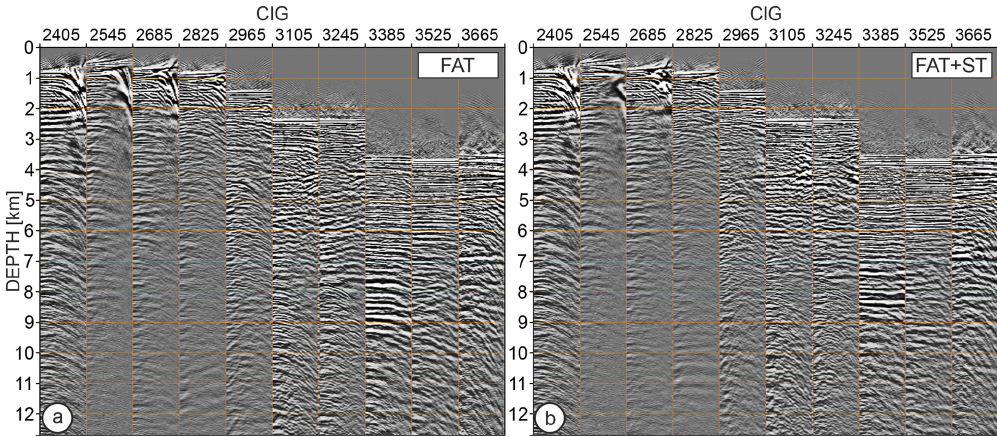
Figure 13. CIGs extracted along the whole profile (same as in Fig. 9) inferred from the velocity model built by (a) FAT and (b)